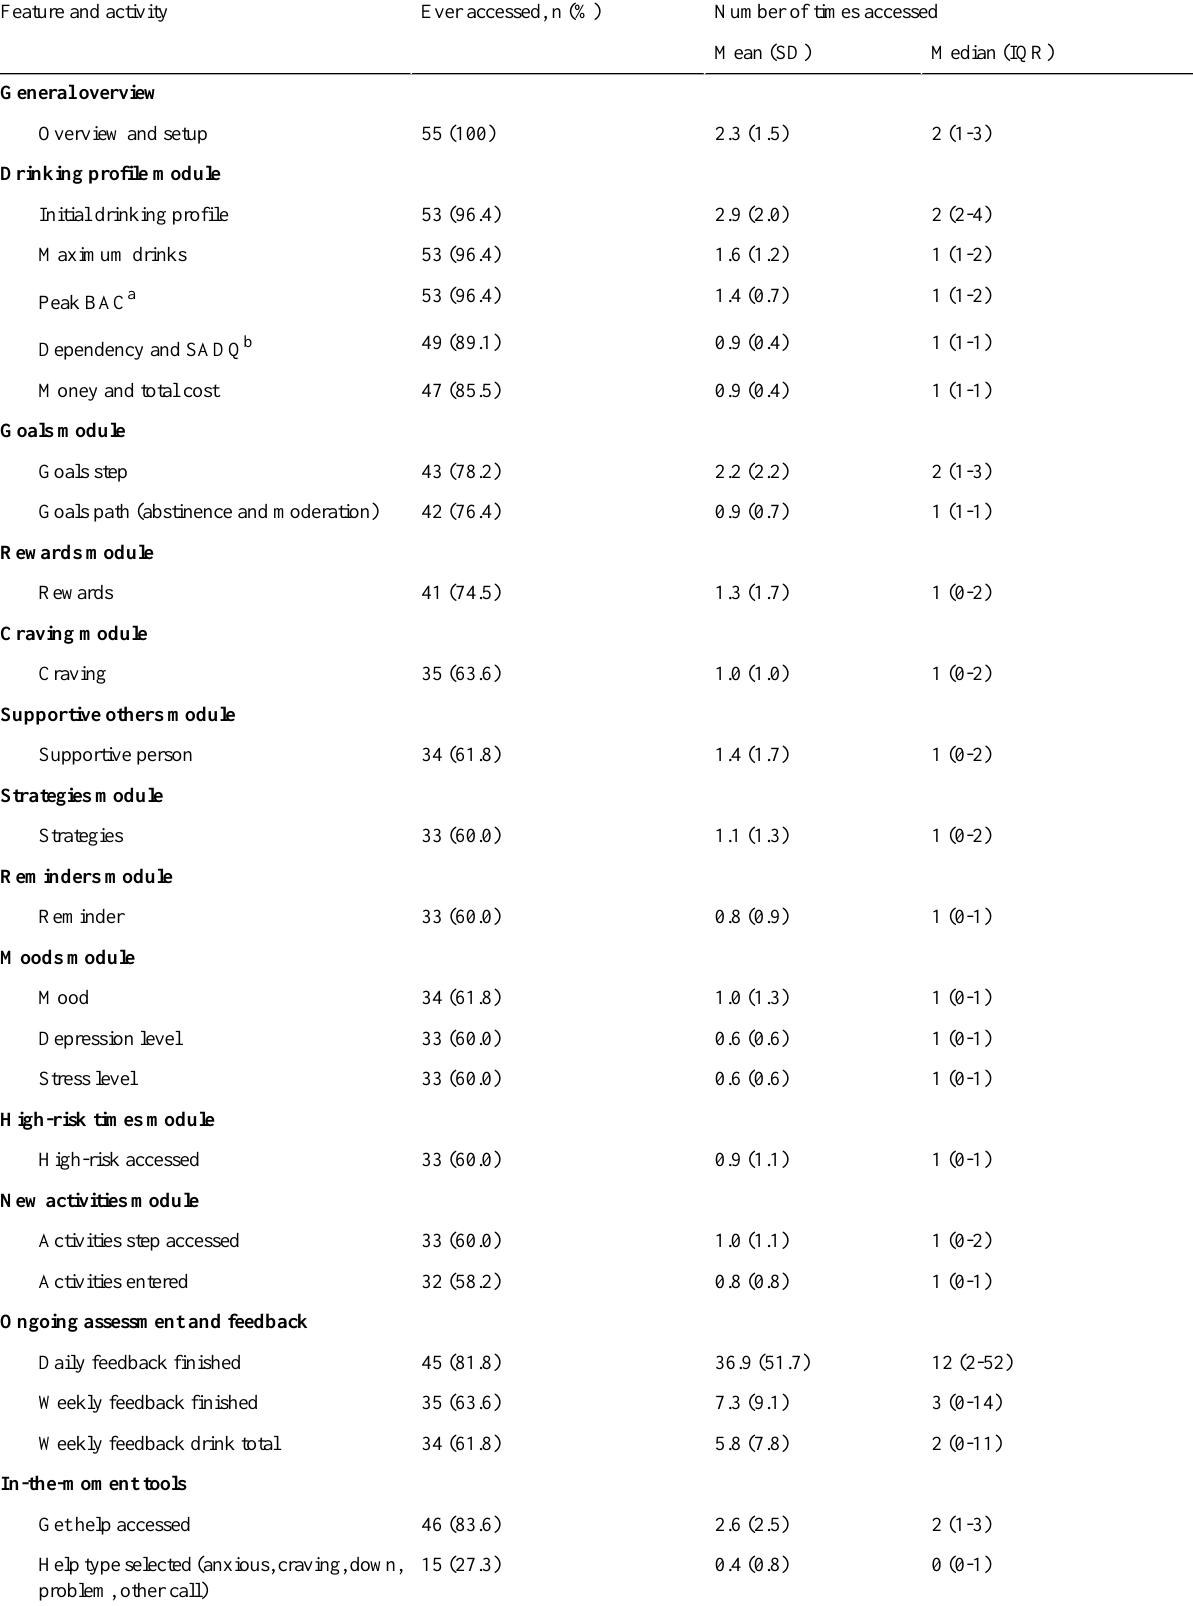
Table 2. Participants’use of Step Away by module from baseline to month 6.